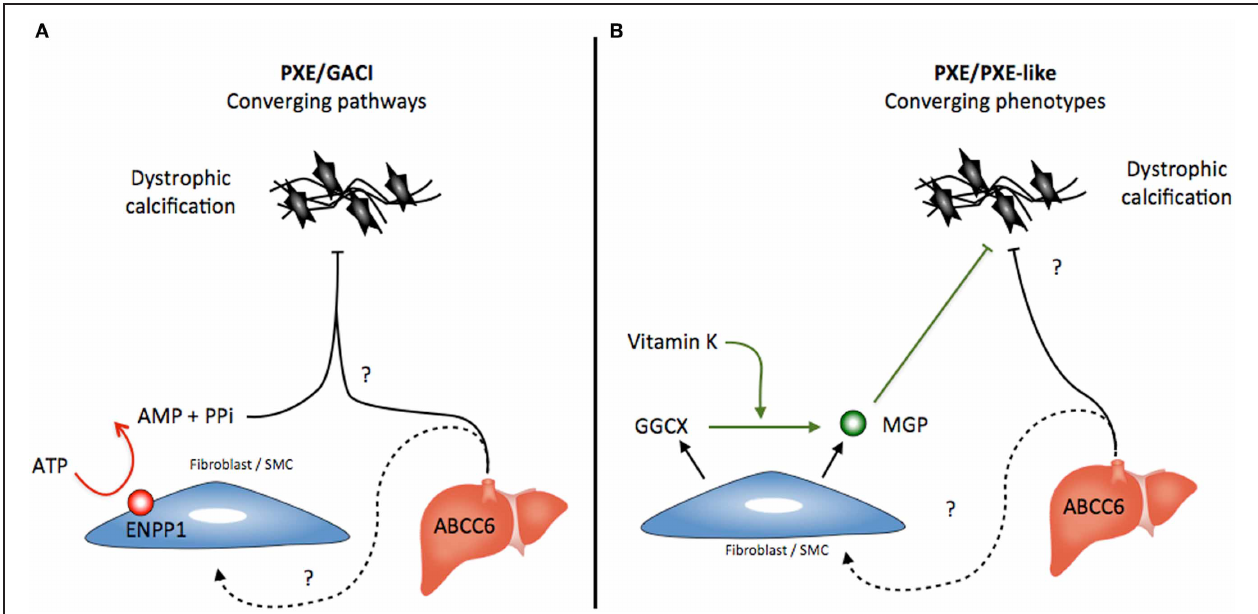
FIGURE 2 | Possible scenario for the converging (A) pathways that lead to the calcification phenotypes caused by ENPP1 and ABCC6 deficiencies and (B) the converging of the dissimilar PXE and GGCX-dependent PXE-like syndrome. Abbreviations: PPi, pyrophosphate; MGP, Matrix Gla Protein.